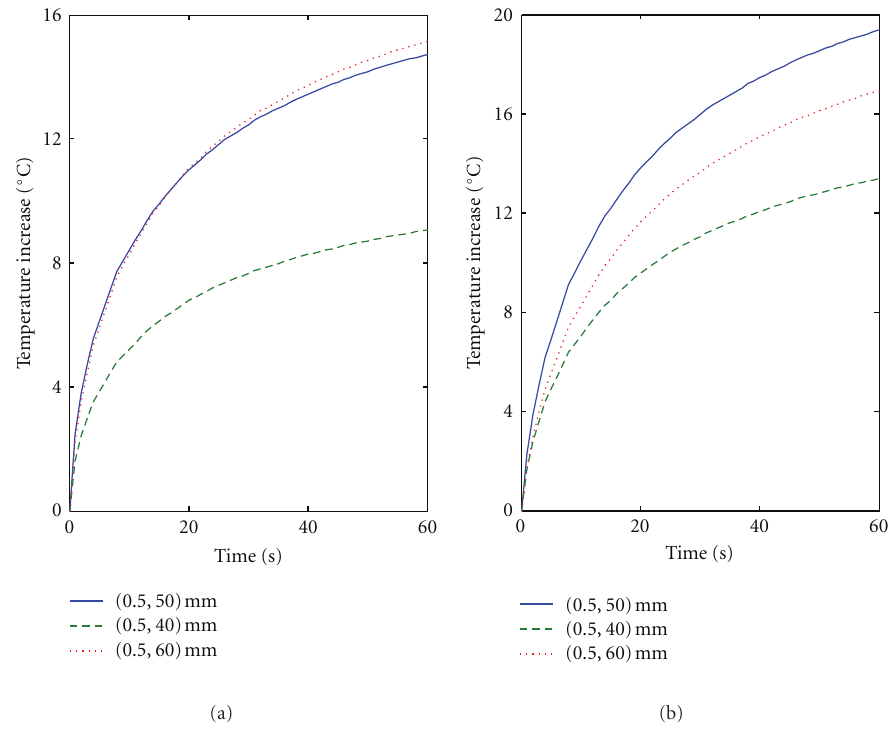
Figure 3: Temperature increase as a function of time for points (a) on the vessel wall and (b) 1mm away the vessel wall. The vessel parameters and ultrasound parameters are as in Figure 2 (primary artery). For each plot, the points are on the focal plane ( z = L/ 2 = 50 mm), 10 mm below, and 10mm above it.